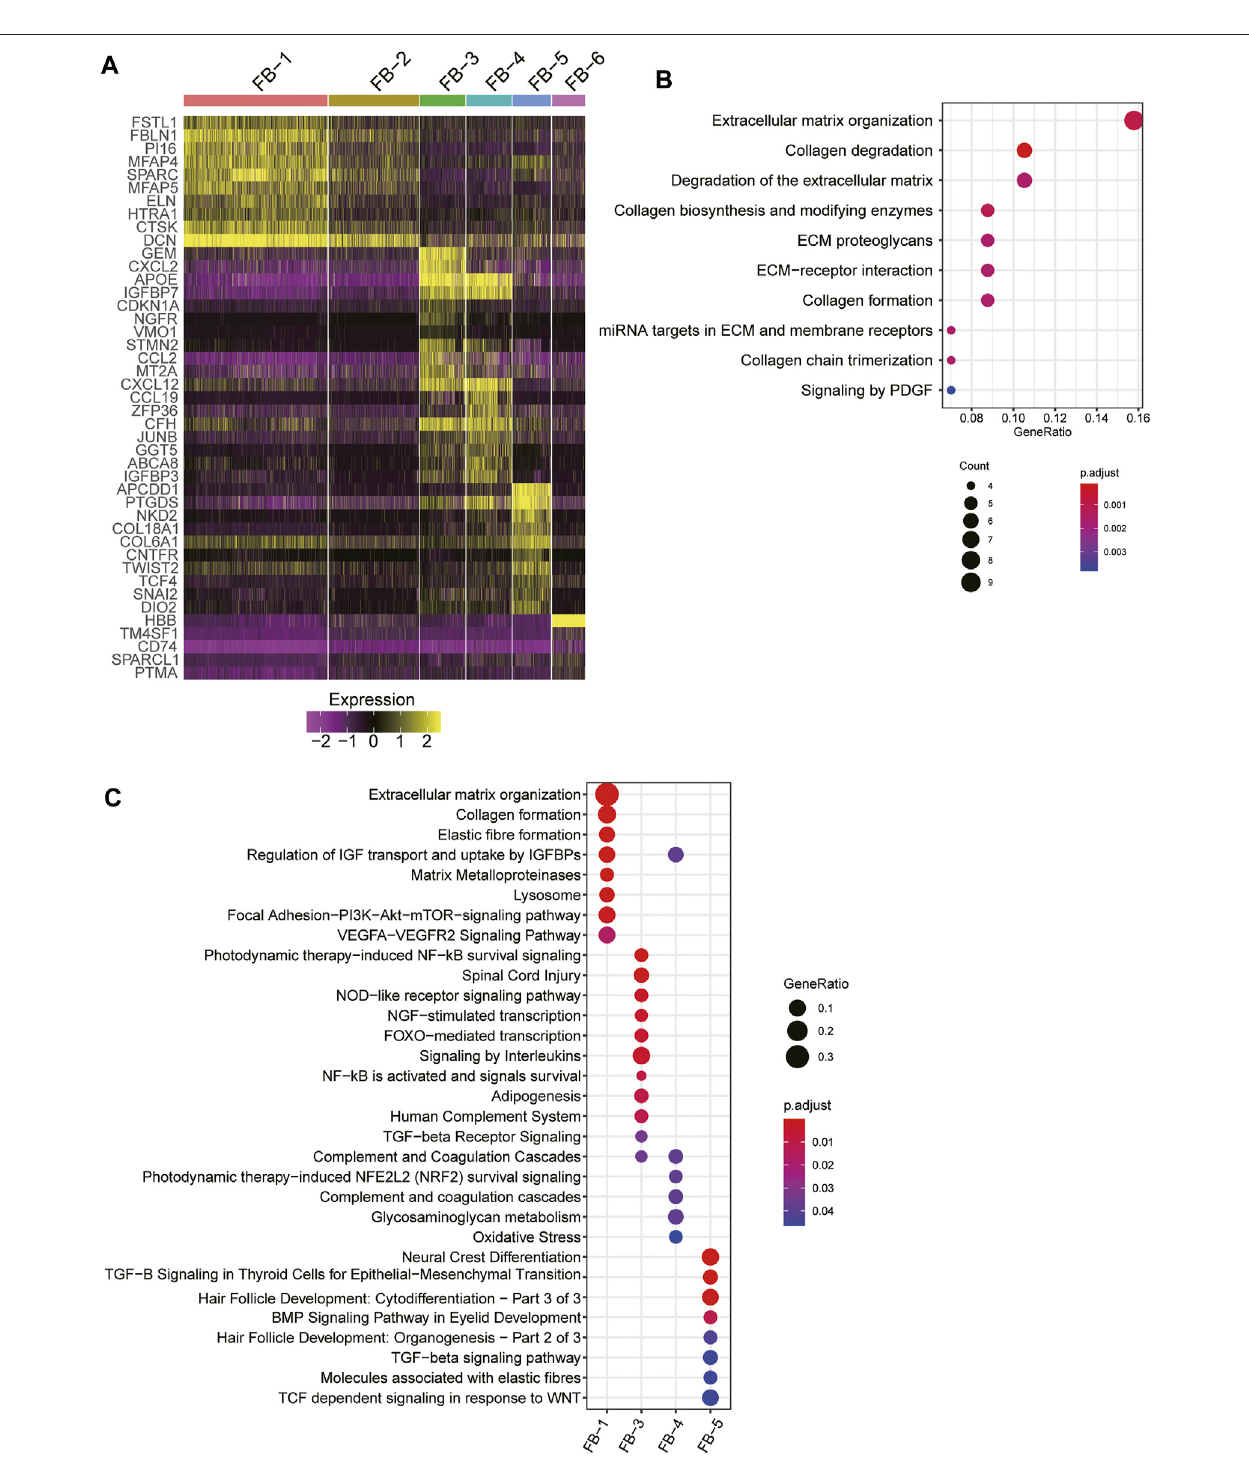
FIGURE3| The fi broblastsubpopulationsintheskinsamples. (A) Theexpressionspeci fi cityoftheFBsubpopulationspeci fi cgenesacrosstheFBcellpopulations. (B) The upregulated pathways in FB-1 cells of HS. (C) The subpopulation speci fi c biological functions across the FB subpopulations.